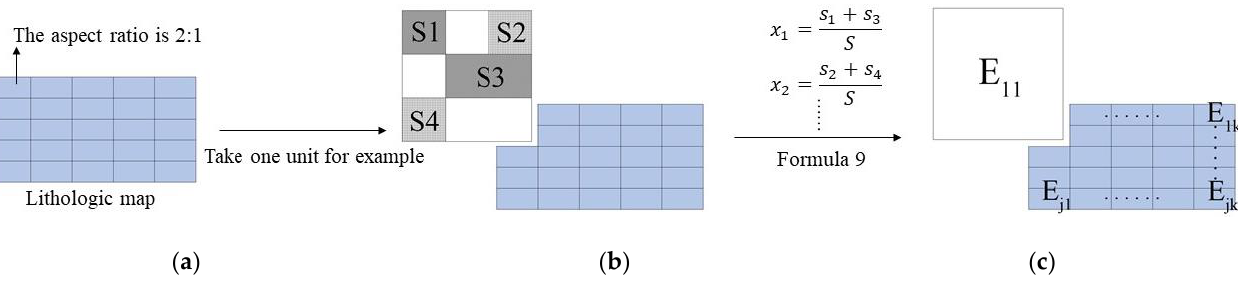
Figure 5. The calculation of the combined entropy of geological units. ( a ) Surface pattern in two dimensions; ( b ) surface lithological identification—lithological units are identified by color and pattern, S 1 and S 3 are surfaces belonging to the same lithological unit, S 2 and S 4 correspond to another lithological unit; ( c ) the calculation of combined entropy.